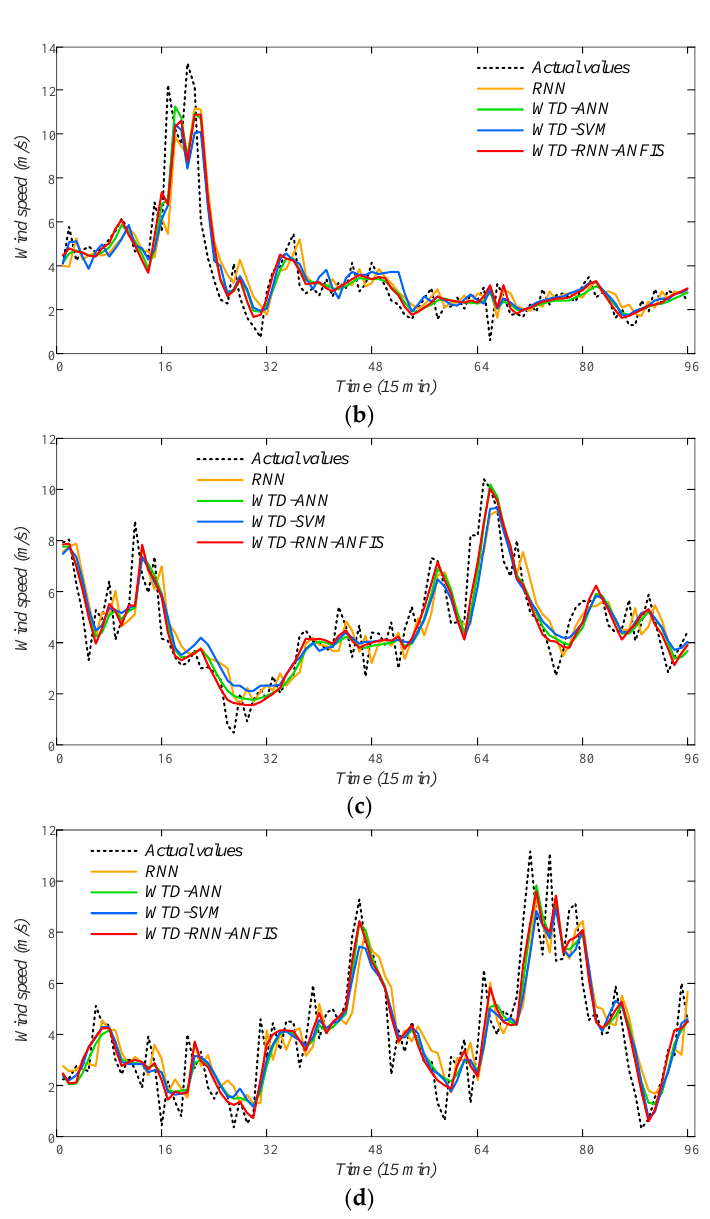
Figure 11. The prediction curves of 1-step-ahead point wind speed forecasting. ( a ) Spring; ( b ) summer; ( c ) autumn; ( d ) winter.